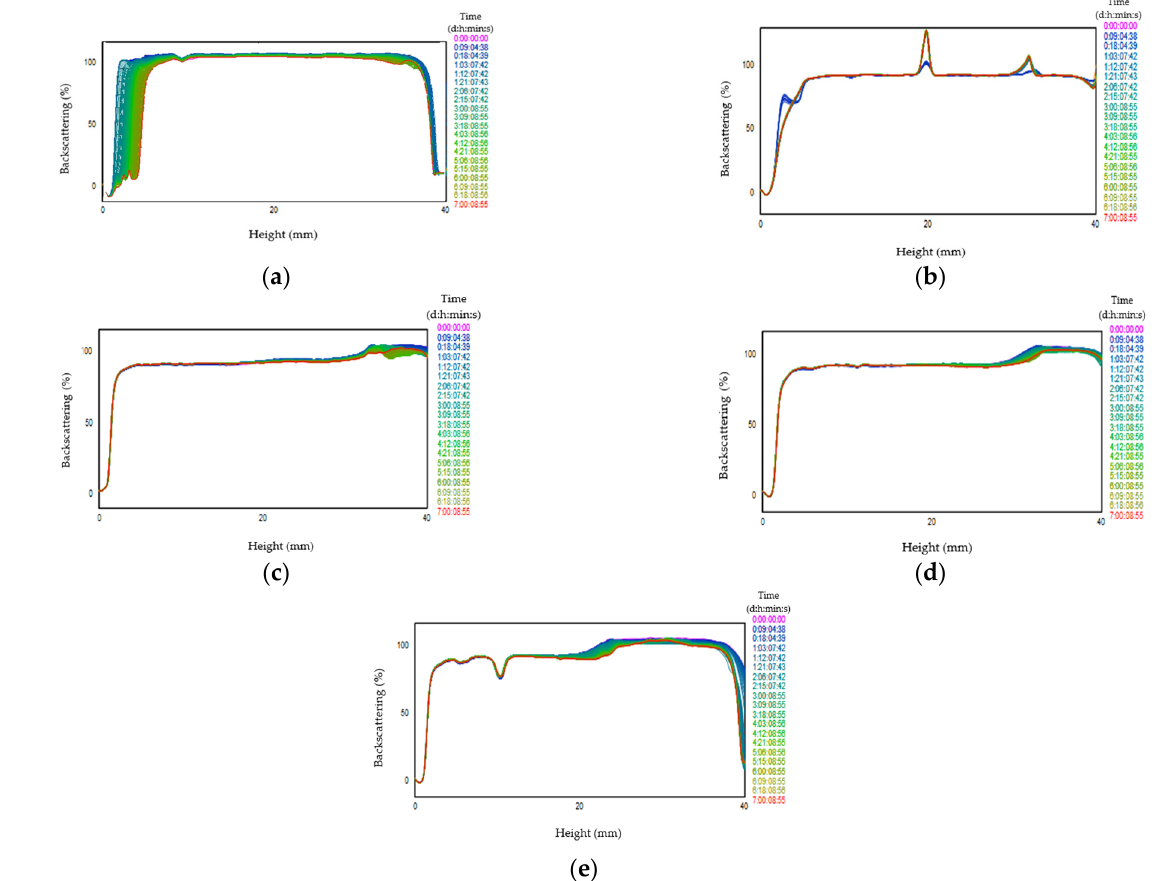
Figure 3. Measurements of the stability of the commercial cream and mixtures of the commercial cream with the double emulsion W 1 /O/W 2 of concentration 80/20 with an internal phase ratio W 1 /O of 30/70: ( a ) double emulsion; ( b ) commercial cream; ( c ) commercial cream with 1/4 emulsion; ( d ) commercial cream with 1/3 emulsion and ( e ) commercial cream with 1/2 emulsion.